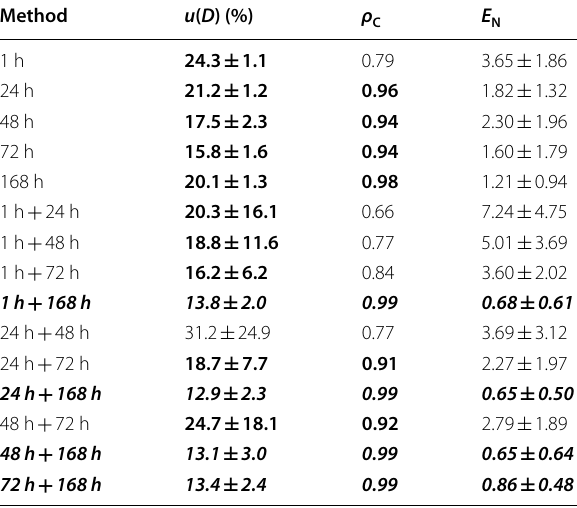
Mean SD values are given. Parameters that meet requirements are marked ± in bold. Protocols where all parameters meet requirements are marked in